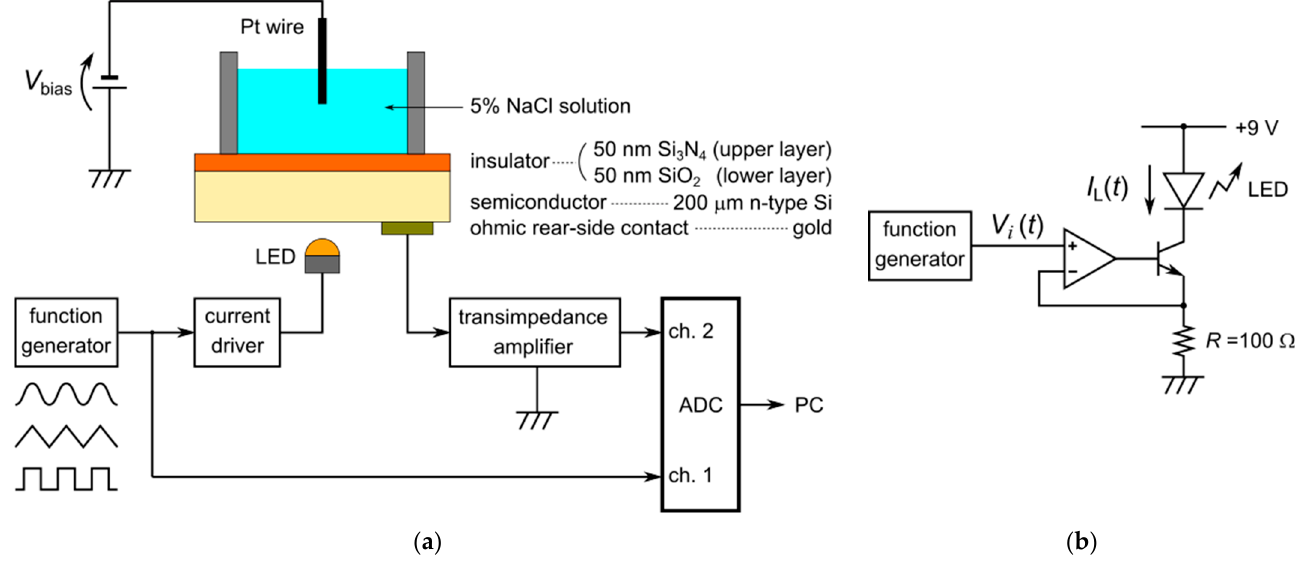
Figure 1. ( a ) Measurement setup for a LAPS. ( b ) LED current driver circuit.